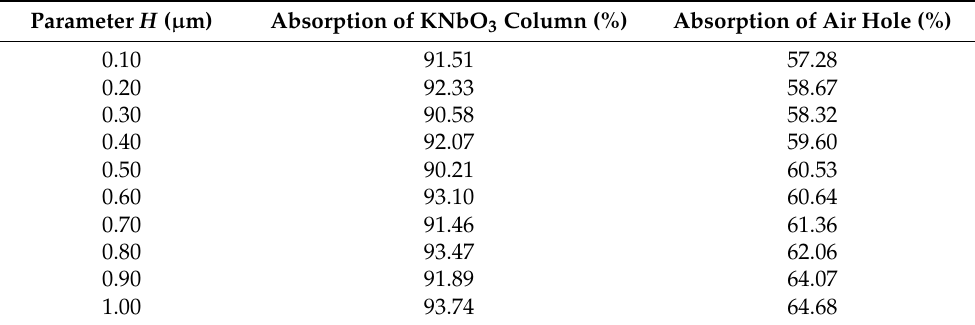
Table 4. The relationship between the absorption efficiency of absorption layers with two different hexagonal scatterers and H